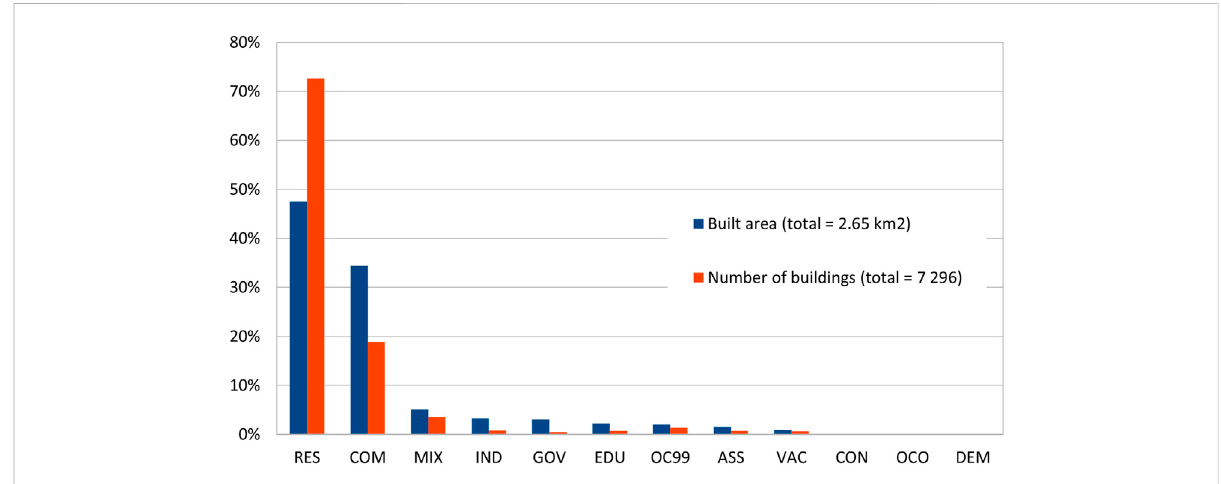
FIGURE 5 Occupancy type relative frequency distribution. AGR, agriculture; ASS, assembly place; COM, commercial and public; DEM, demolished; EDU, education; GOV, government; IND, industrial; MIX, mixed-use; OC99, unknown; OCO, other; RES, residential; VAC, vacancy.